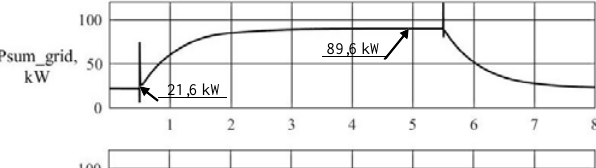
Figure 8. Experiment: transient process with ESS in the dI/dt Limitation Mode (from top to bottom - the power of the DGU, the load power)